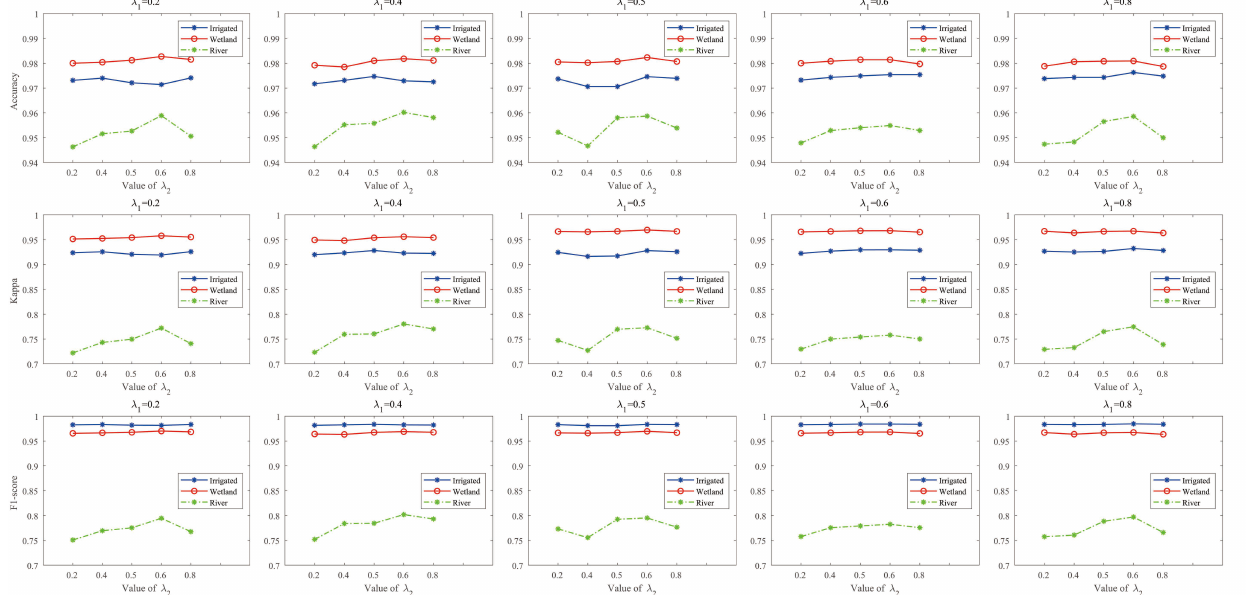
Figure 13. Impacts of hyperparameters λ 1 and λ 2 on all three datasets. The first row indicates the influence on the accuracy, the second row the influence on the kappa coefficient, and the last row the influence on the